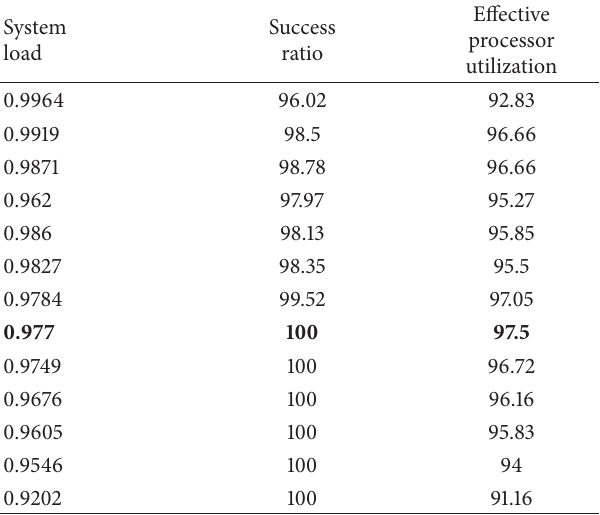
Figure 10: Success ratio versus number of tasks. Table 5: Success ratio and effective processor utilization for various loads analyzed.